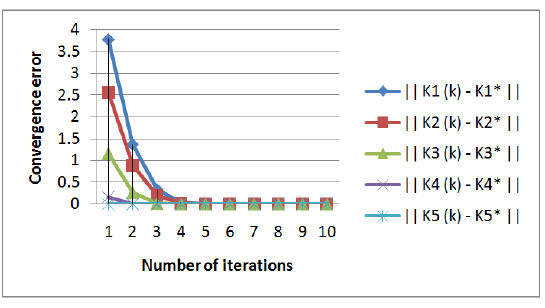
K to * K during learning i i